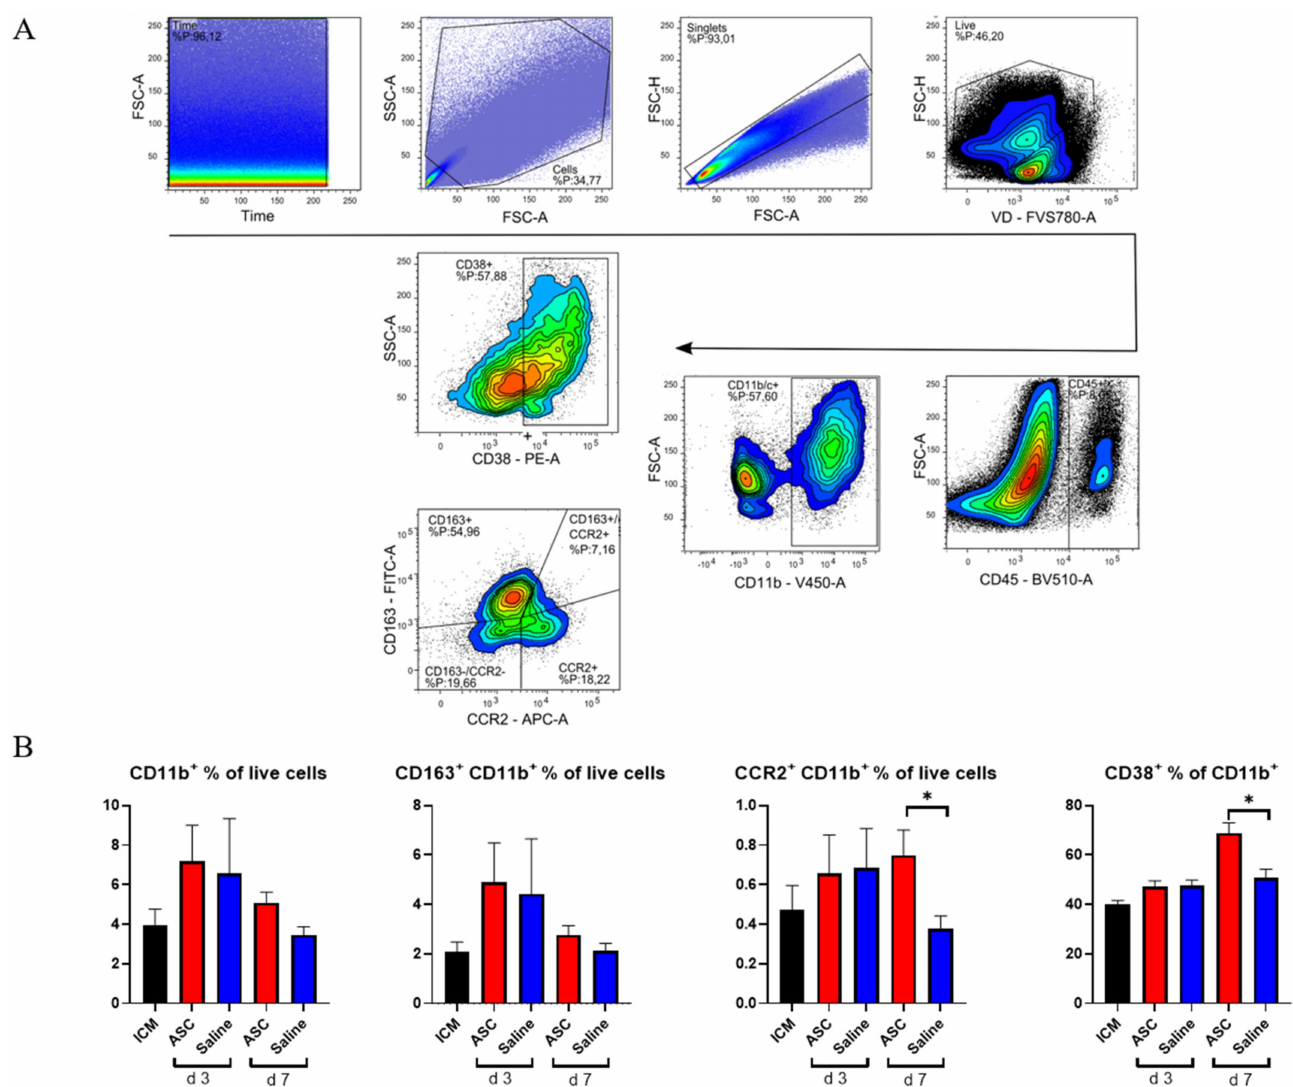
Figure 4. Myeloid response to ASC and saline administration. ( A ) Gating strategy for analysis with double plot of CCR2 and CD163. ( B ) Effect on CD11b + cells, CD163 + cells, CCR2 + cells, and CD38 + cells. ICM n = 5, ASC day 3 n = 6, saline day 3 n = 6, ASC day 7 n = 5, and saline day 7 n = 4. ICM; ischemic cardiomyopathy. * p <